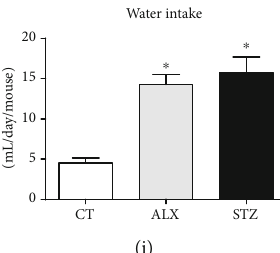
Figure 1: Long-term diabetogenic e ff ects of ALX and STZ on mice. T1D was induced as described in Methods, and parameters were evaluated at di ff erent time points. (a) Blood glucose levels and (b) body weight were evaluated on the 15 th , 30 th , 60 th , 90 th , and 180 th days following administration of the drugs. (c) Survival rate was monitored for 180 days (CT and STZ groups represented as overlapping lines). (d, e) Insulin tolerance test and (f, g) glucose tolerance test were evaluated on the 90 th and 180 th days. (h) Food and (i) water intake was evaluated for fi ve days. Data are presented as mean ± SEM , ∗ p ≤ 0 : 05 (5-6 animals per group).